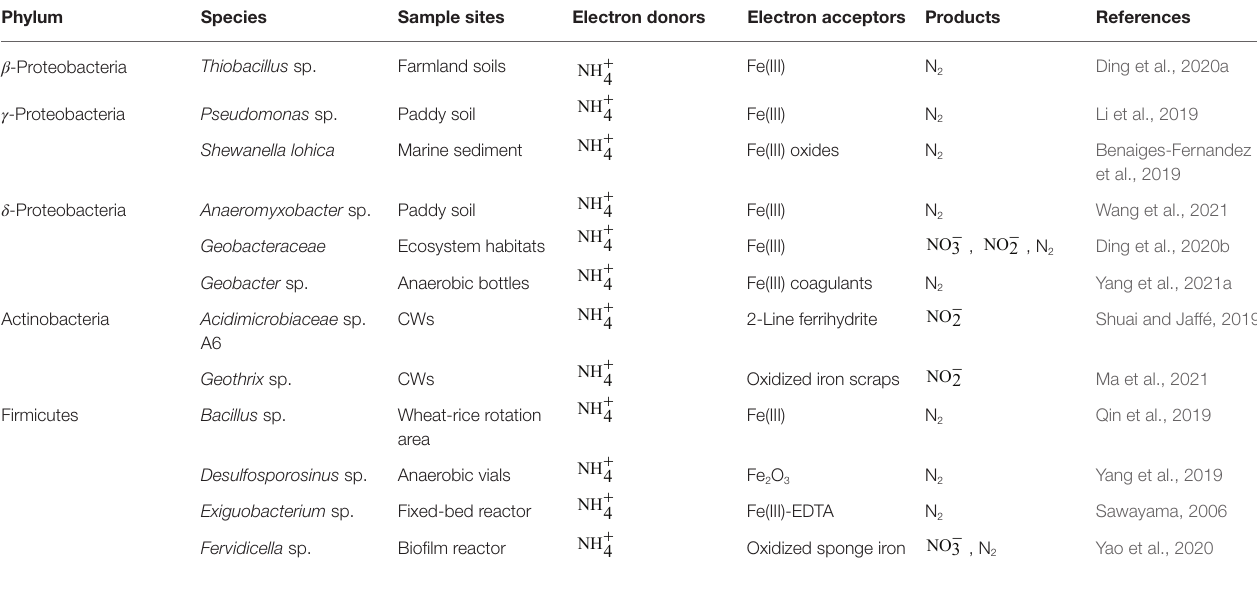
electrons in the cytoplasmic membrane; (2) PpcA and PpcD receive and transfer electrons in the periplasm; and (3) Omas (B and C) and Omcs (B, C or Z) form trans-outer membrane protein complexes, which combine with porin-like proteins OmbB and OmbC to eventually transfer electrons to the extracellular space (Liu et al., 2018). Overall, electrons are derived from quinols in the cell’s inner membrane through electron acceptor outside the cell. + oxidation in Feammox. TABLE 3 | Fe(III)-reducing microorganisms for NH 4